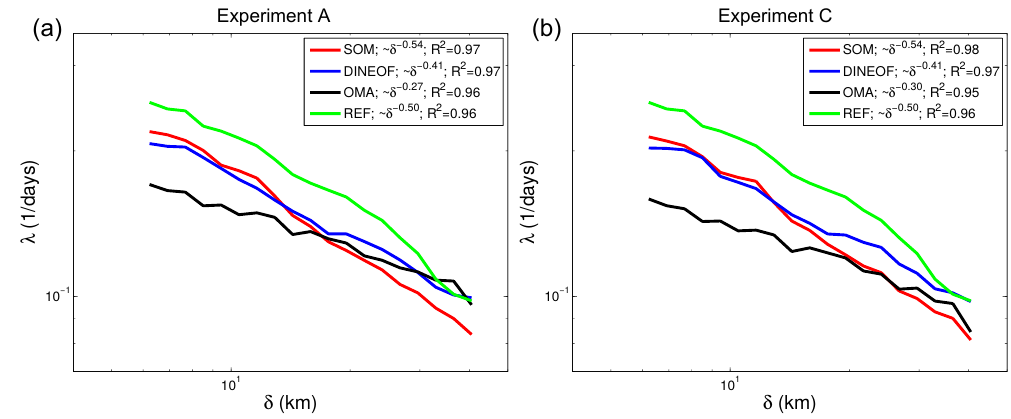
Figure 9. Comparison of scale-dependent FSLE curves computed from the different filled HFR velocities averaged over 240 virtual particle- pair deployments homogeneously distributed through April 2012, 2013 and 2014. (a) Experiment A, (b) experiment